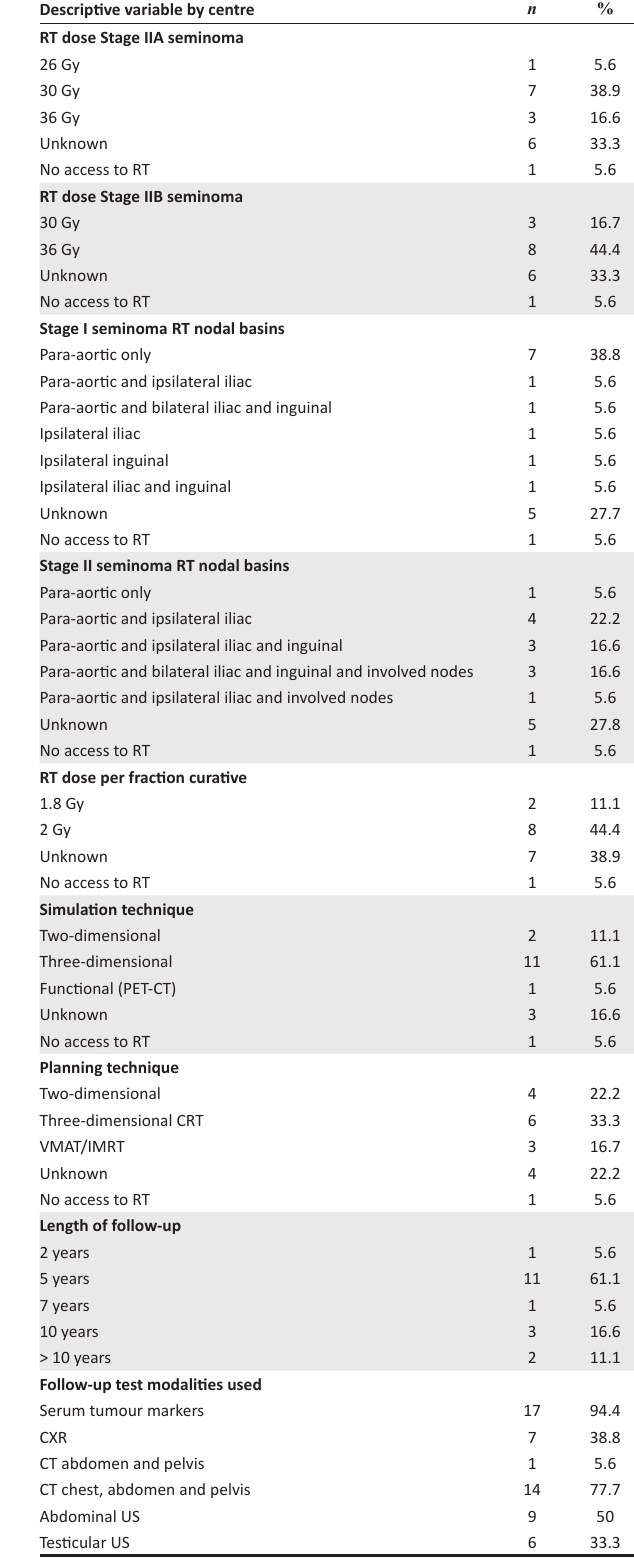
TABLE 4 (Continues...): Patterns of staging, treatment † and follow-up ( n =